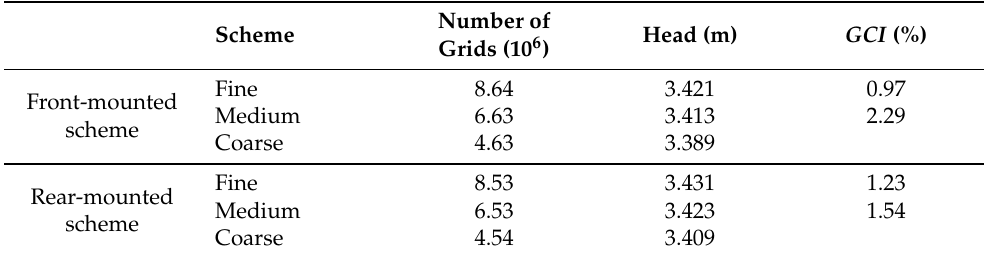
Table 1. Comparison of calculation results of pump device head under different grid numbers.